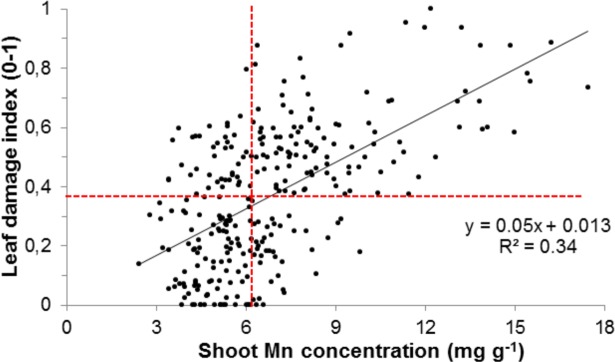
Linear regression of shoot Mn concentration and leaf damage index.Estimated gradient for the explanatory variable (shoot Mn concentration) was unequal to zero (p<0.001). Horizontal and vertical dotted red lines represent the median values for leaf damage index and shoot Mn concentration, respectively.